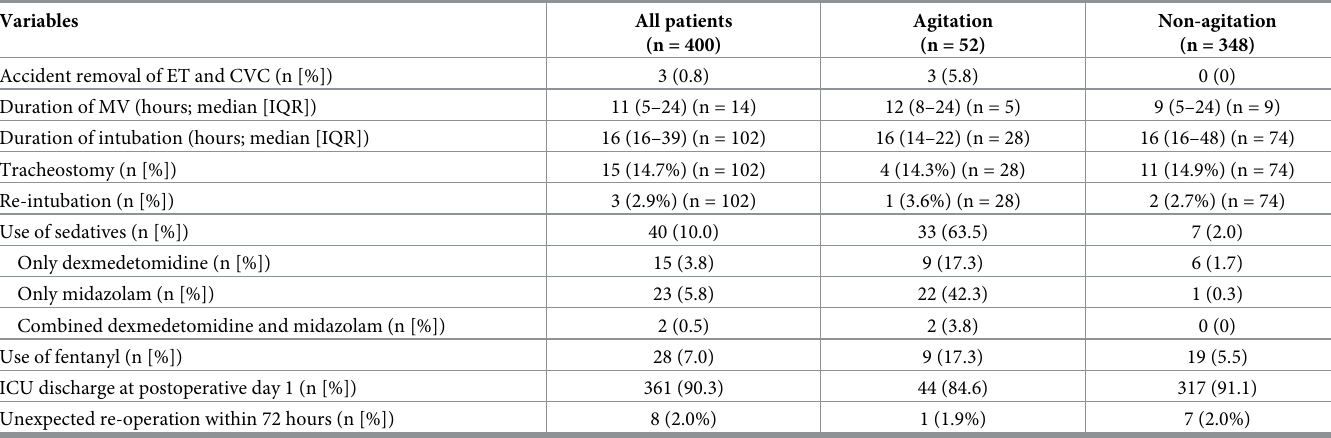
Table 6. Follow-up